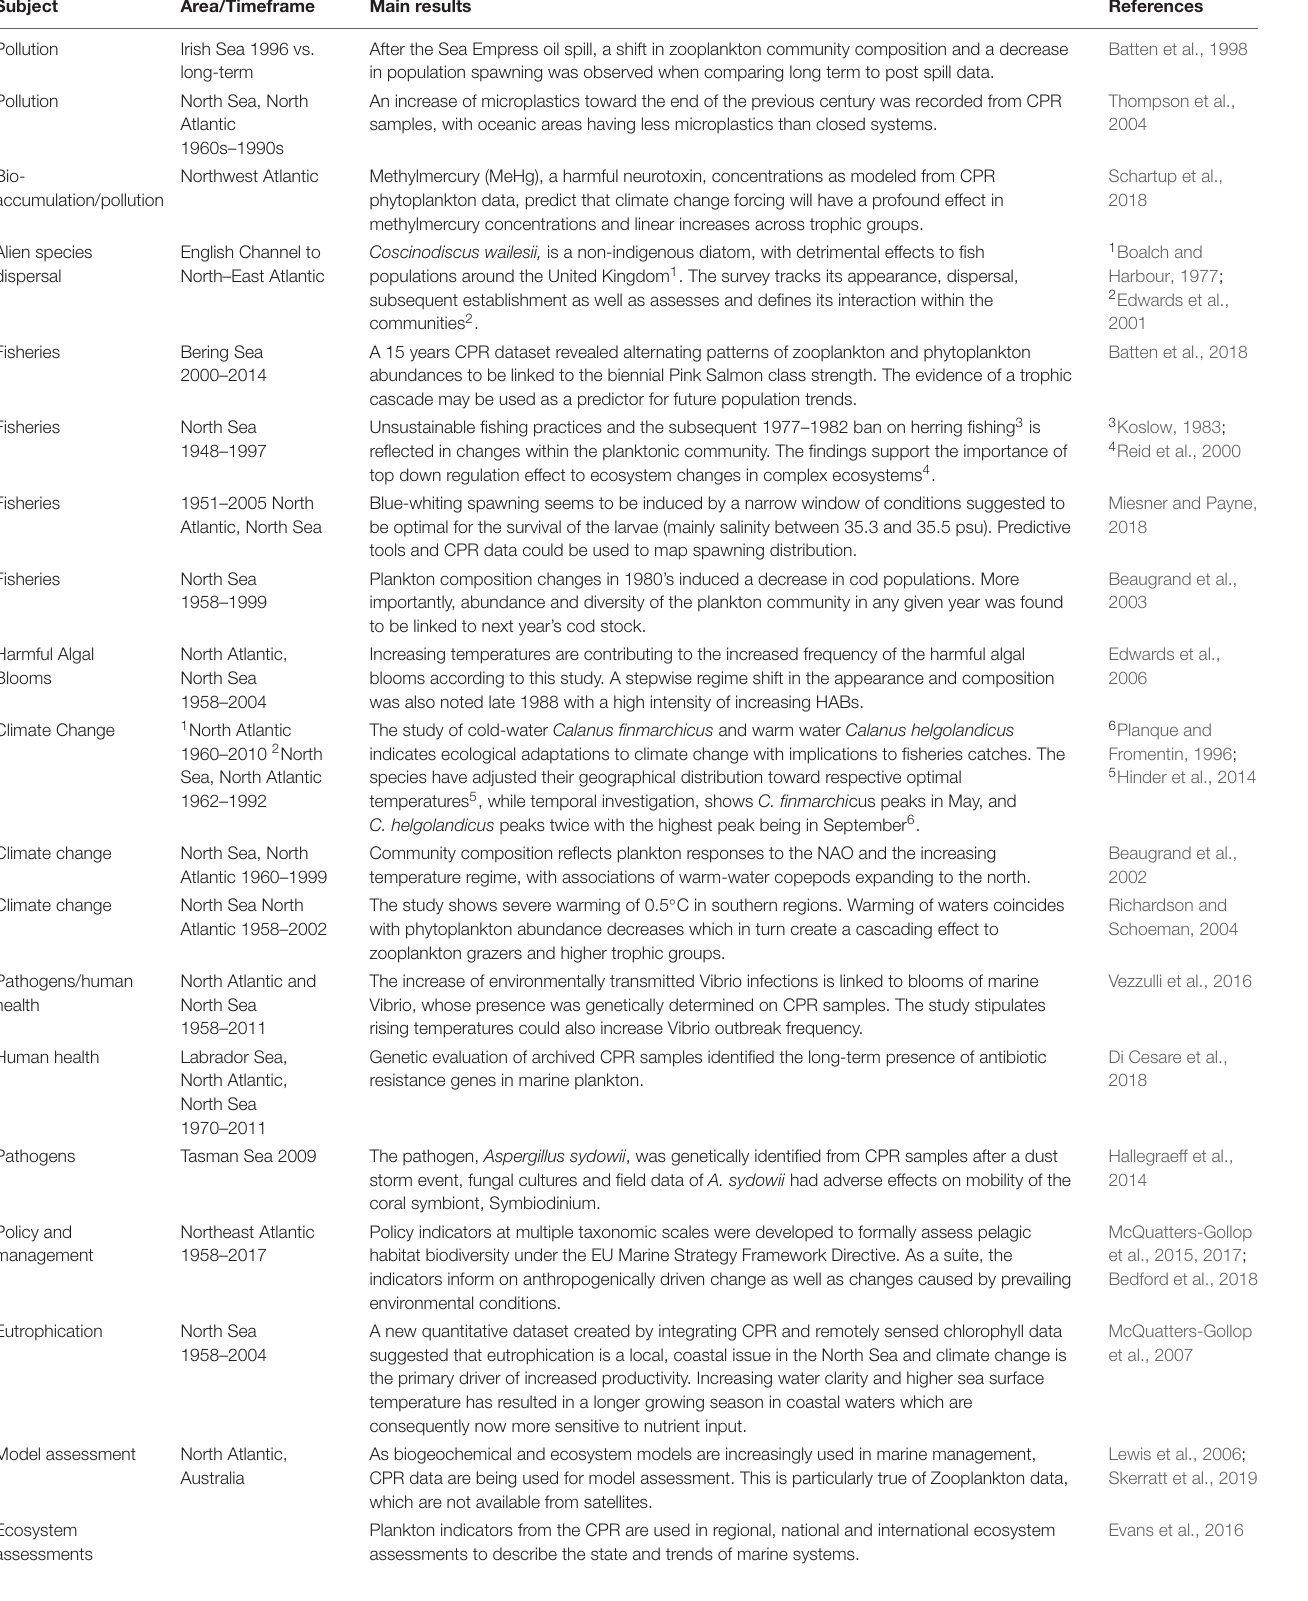
TABLE 1 | A selection of publications using CPR data to demonstrate the breadth of